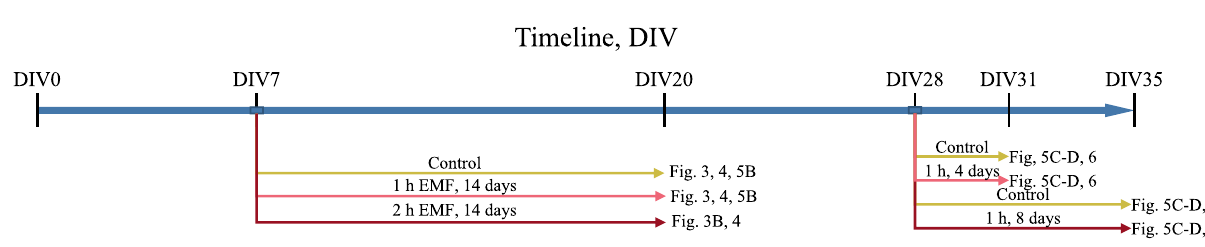
Figure 6. Schedule of treatments of tissue cultures by REMFS. Our study used different aged cultures (measured by days in vitro, DIV), different exposure times per exposure, and different days of repeated exposure. Figure keys each combination to specific results figures (Fig. 3–4). DIV0 is day tissues were triturated and initially